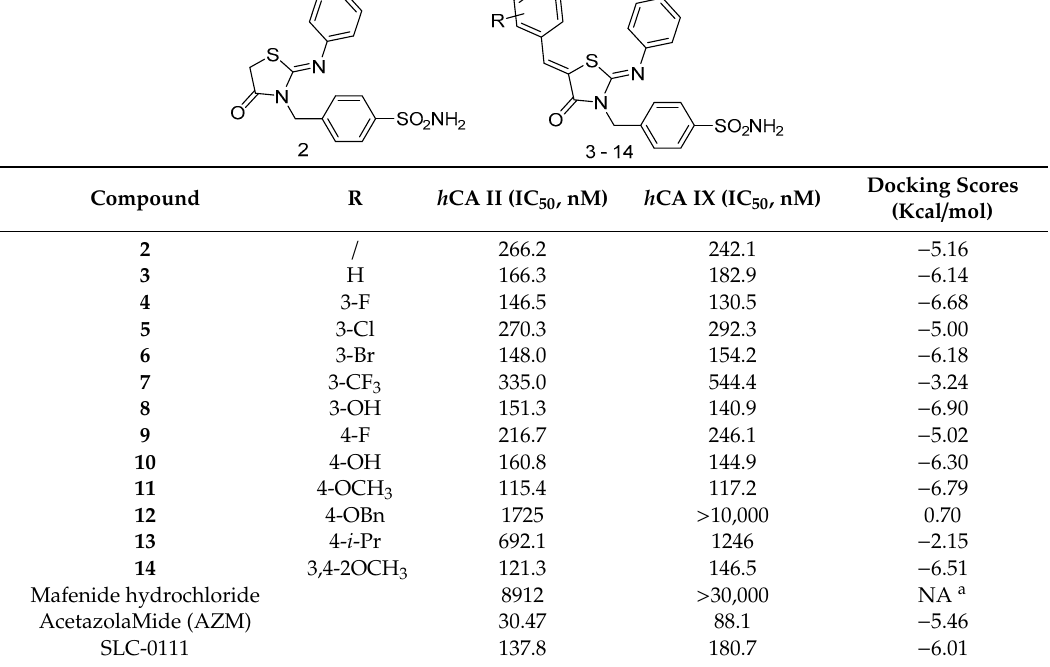
Table 1. Inhibitory activity of compounds ( 2 – 14 ) against h CAs and molecular docking binding scores.